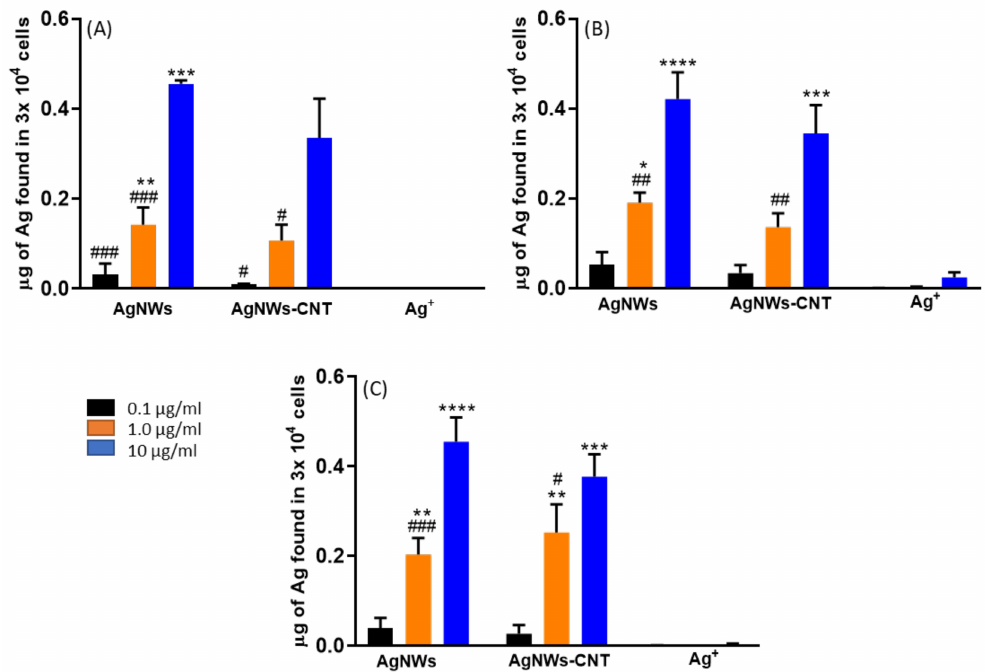
Figure 9. Uptake of silver by ( A ) osteoblasts, ( B ) fibroblasts and ( C ) Caco-2 treated with AgNWs, AgNWs-CNT and AgNO 3 . Data are expressed as the mean ± SD ( n = 3). One way Anova indicated at least p < 0.05 for all samples tested apart from AgNO 3 . Results of the post-hoc Tukey multicomparison test are shown in the graph (symbol *compared to 0.1 and # compared to 10 µ g /